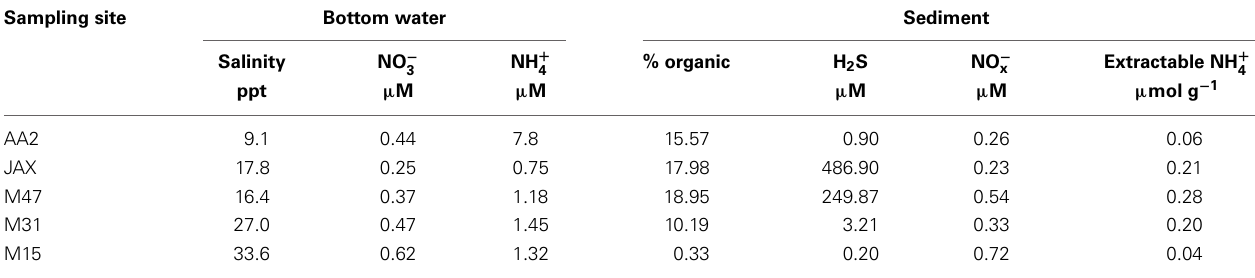
Table 1 | Physical and geochemical characteristics measured at 5 sampling sites in the New River Estuary. Sampling